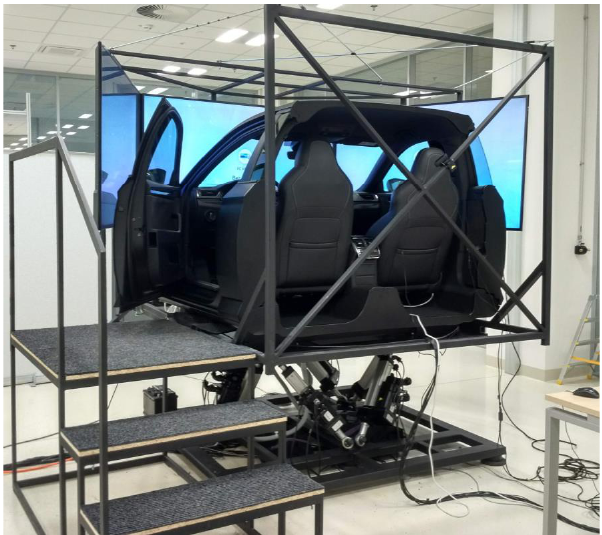
Figure 1. The driving simulator used for the present study developed in our laboratory (R&D 4.0 LAB) at the Faculty of Transportation Sciences, CTU in Prague.